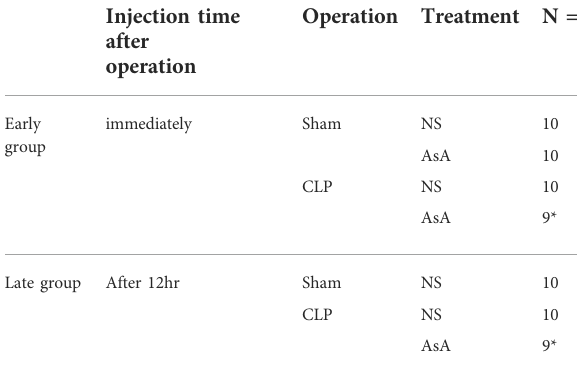
TABLE 1 Number of mice per group. p These groups originally numbered 10 animals, but the feces were hard and the severity of the disease could not be assessed; thus, we excluded 2 mice from the study.